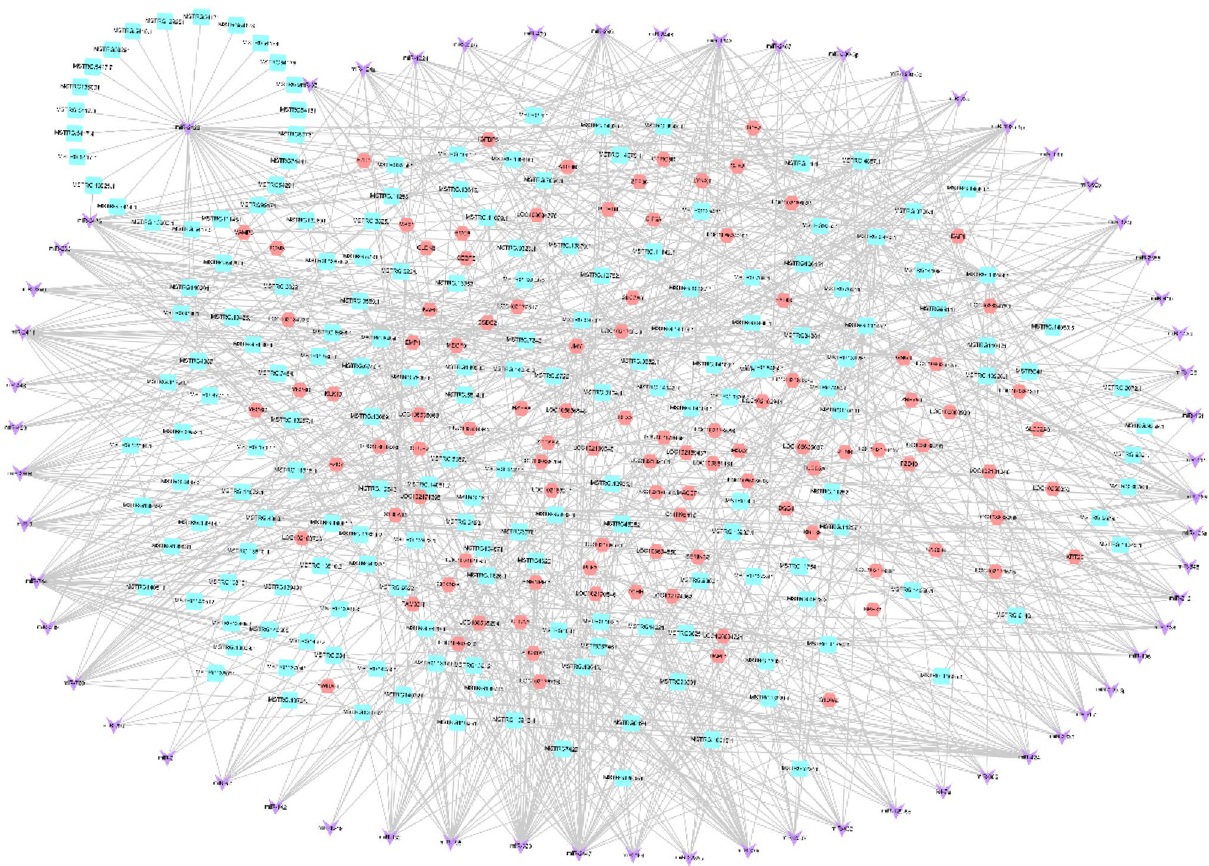
Figure 7. Regulation network of lncRNA–miRNA–mRNA. Pink: mRNAs, blue: lncRNAs, purple: